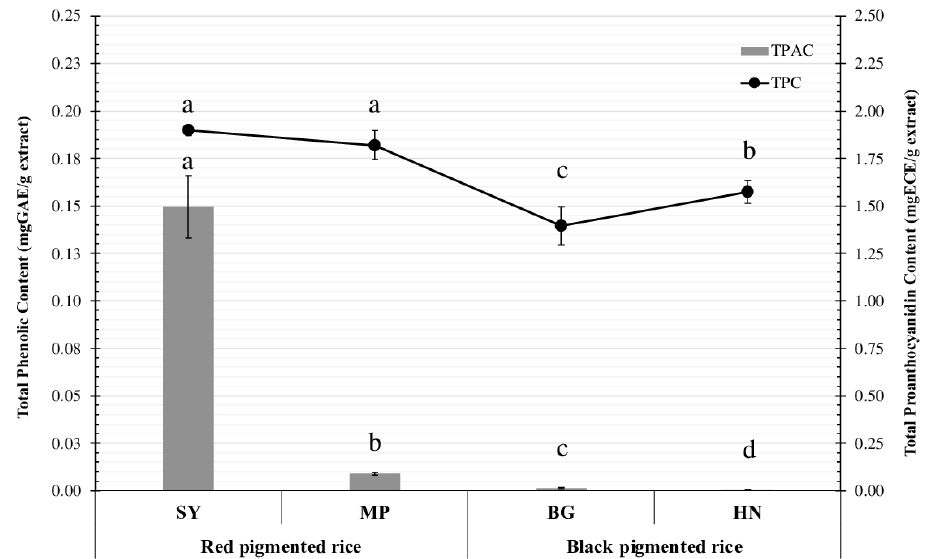
Figure 1. Total phenolic ( TPC , linear) and proanthocyanidin ( TPAC , histogram) contents of red (Sang-Yod- SY and Mun-poo- MP) and black (Black Glutinous-BG and Hom-Nil- HN) pigmented rice extracts. Mean ± S.D. ( n = 3), Different letters (a, b, c, d) in each graph indicate statistically different values (ANOVA, Duncan’s multiple range tests, p < 0.05).